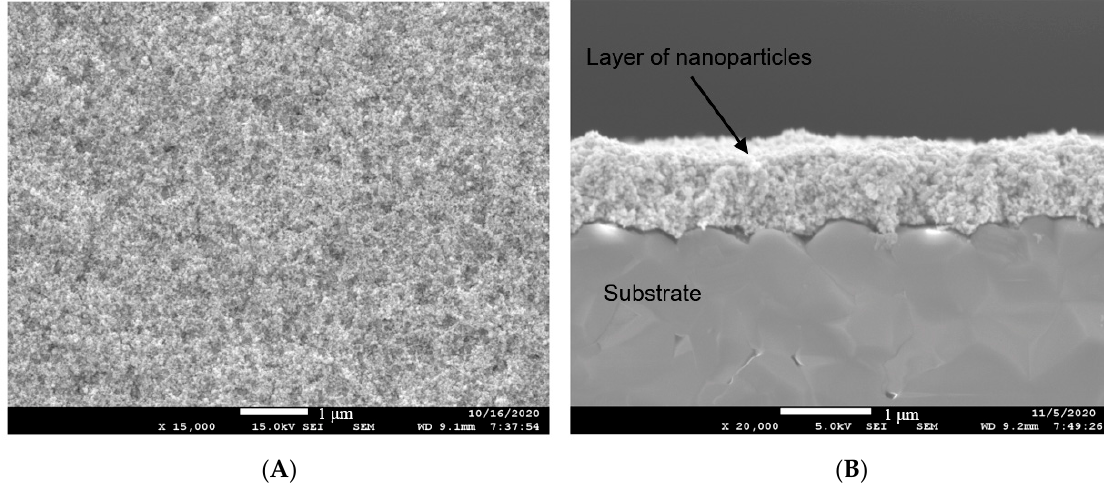
Figure 11. SEM images of the nanoparticles contained in the ink. ( A ) Front surface of the film. ( B ) End surface of the film. The ink was printed on alumina substrate and then annealed in air atmosphere at 400 °C for 2 h to remove the binder.